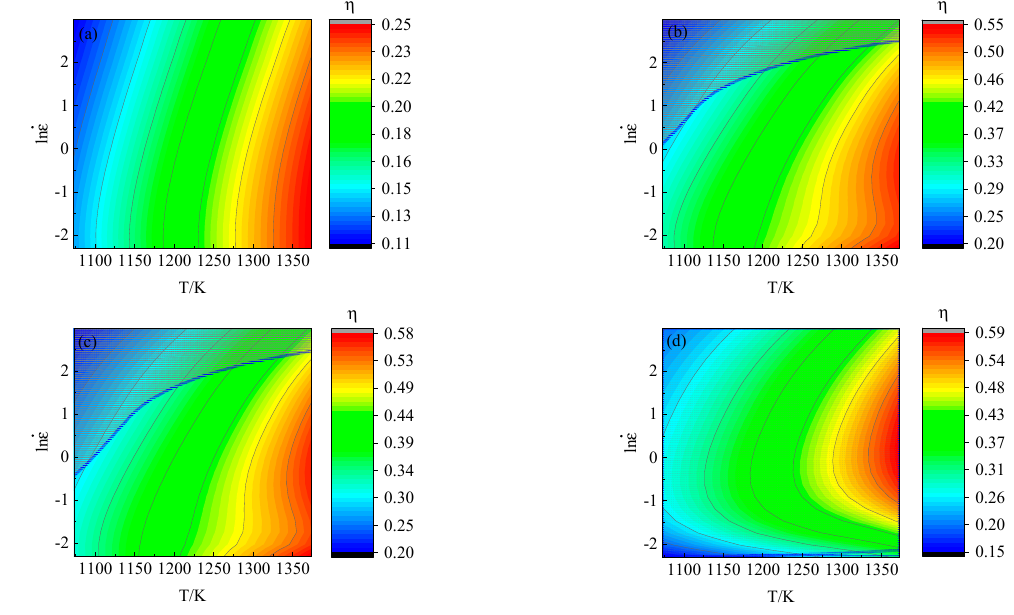
Figure 19. The processing map under the different strain conditions: ( a ) ε = 0.15, ( b ) ε = 0.3, ( c ) ε = 0.45, ( d ) ε =